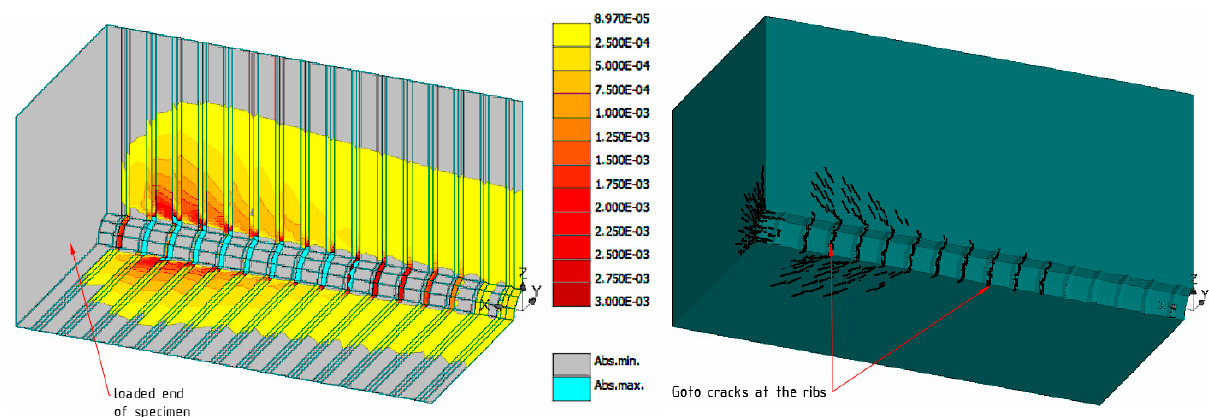
Figure 5. Results of FE analysis: concrete strains and micro-cracking at 110 kN load level.